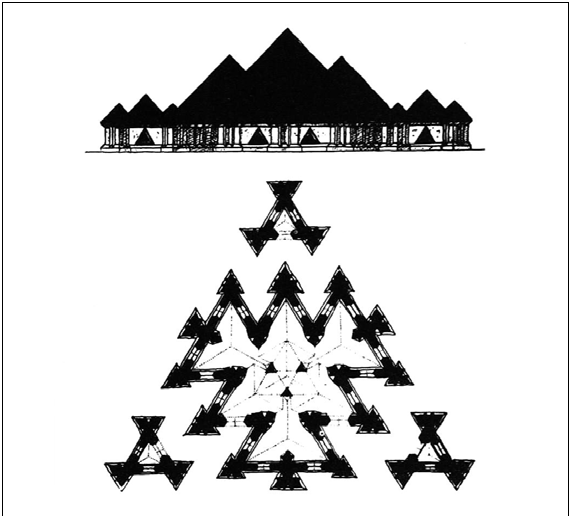
fig. 11. Berlin-Siemensstadt. Holy Trinity Evangelical church, reinhold Barwich, 1969. General view. Source : https://www. flickr.com/photos/33027180@n00/14184619499/in/pool- photo_graphics - photo: Martin Maleschka.